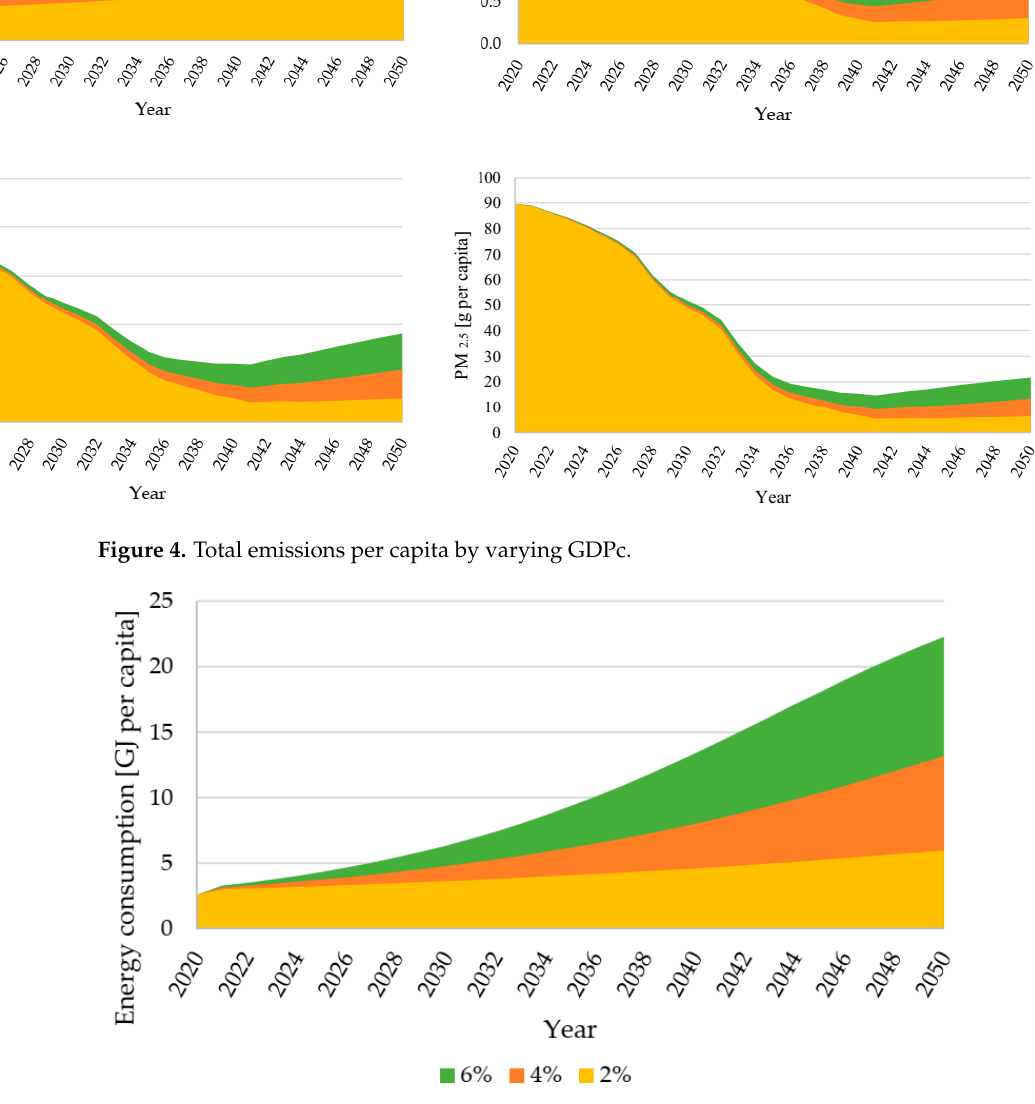
Figure 5. Energy consumption by varying